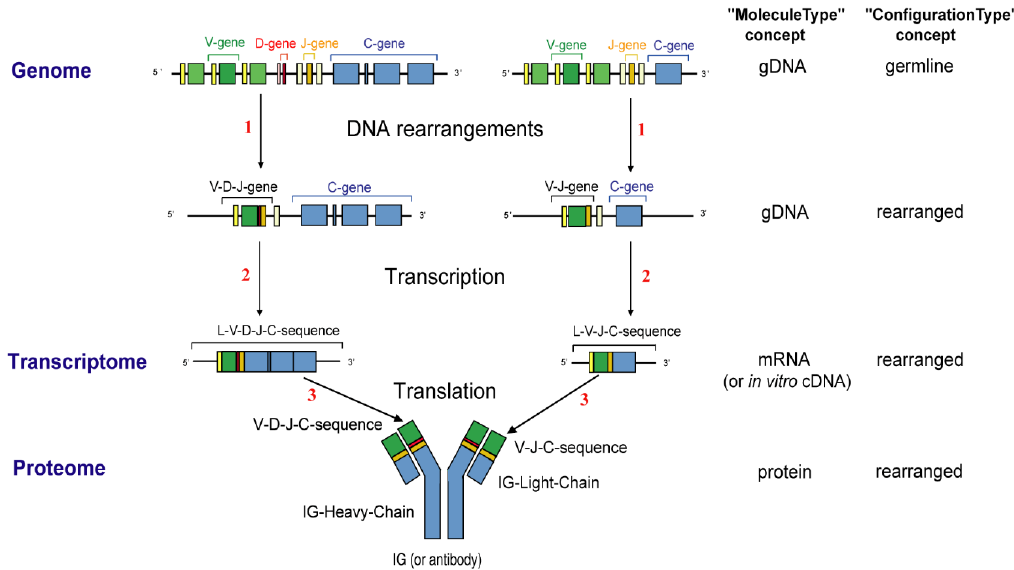
Figure 15. Molecular entity types of the IG synthesis (IDENTIFICATION axiom) [16,30,31] in jawed vertebrates ( Gnathostomata ). (1) DNA rearrangements (is_rearranged_into). (2) Transcription (is_transcribed_into). (3) Translation (is_translated_into). IMGT standardised keywords, generated from the concepts of identification, identify the entity types based on the MoleculeType and and the ConfigurationType. The MoleculeType is gDNA, mRNA, in vitro cDNA or protein. The ConfigurationType is undefined (conventional and C-gene), germline (V-gene, D-gene and J-gene) or rearranged. The rearranged entities include V-D-J-gene (label L-V-D-J-GENE) and V-J-gene (label L-V-J-GENE) (gDNA), L-V-D-J-C-sequence and L-V-J-C-sequence (cDNA), V-D-J-C-chain and V-J-C-chain (protein) [30]. The functionality of undefined and germline entities is functional (F), open reading frame (ORF) or pseudogene (P) [30]. The functionality of rearranged entities is productive or unproductive [30] (Table 6). L = L-REGION (shown in ‘Transcriptome’) (light yellow), V = V-REGION (in green), D = D-REGION, J = J-REGION, C = C-REGION (in blue). The gene core regions involved in the V-D-J (heavy chain) and V-J (light chain) rearrangements are highlighted: V (in dark green), D (in red) and J (in orange yellow). (With permission from M-P. Lefranc and G. Lefranc, LIGM, Founders and Authors of IMGT ® , the international ImMunoGeneTics information system ® , http://www.imgt.org).